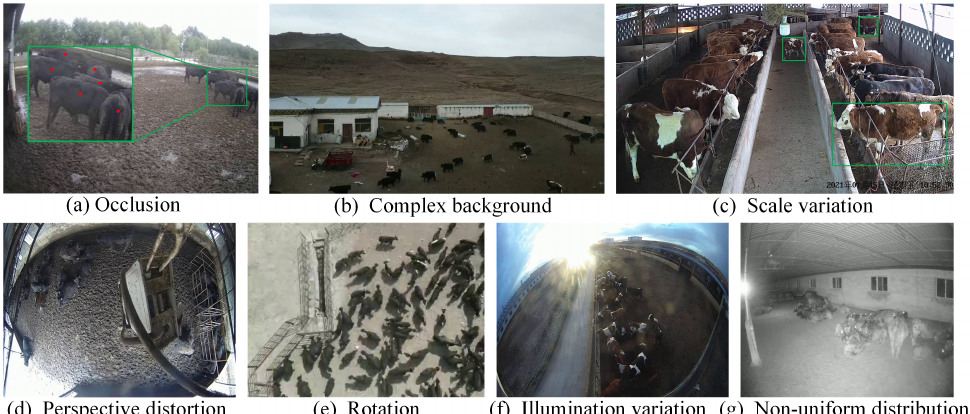
Figure 6. The examples of challenges in cattle